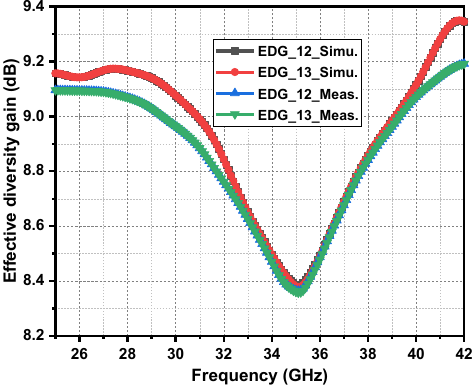
FIGURE 14. The EDG of the proposed MIMO antenna.